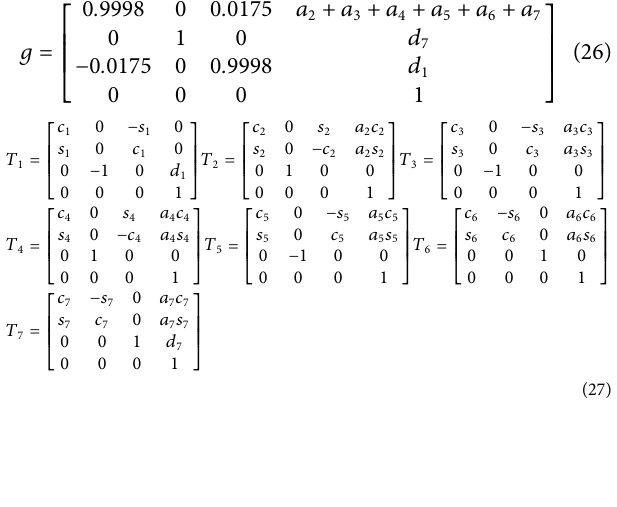
a 1 ~ a 7 , d 1 ~ d 7 denotes the parameters of Seven-degree-of- freedom robot arm. g represents the initial position attitude matrix of the end-effector, T 1 ~ T 7 represents the variation matrix of the joint angles from 1 to 6, α , β , η represents Euler angles of rotation along the x , y , z axes after the end-effector moves from the initial position, and P x , P y , P z represents the new position of the end-effector after the end-effector moves from the initial